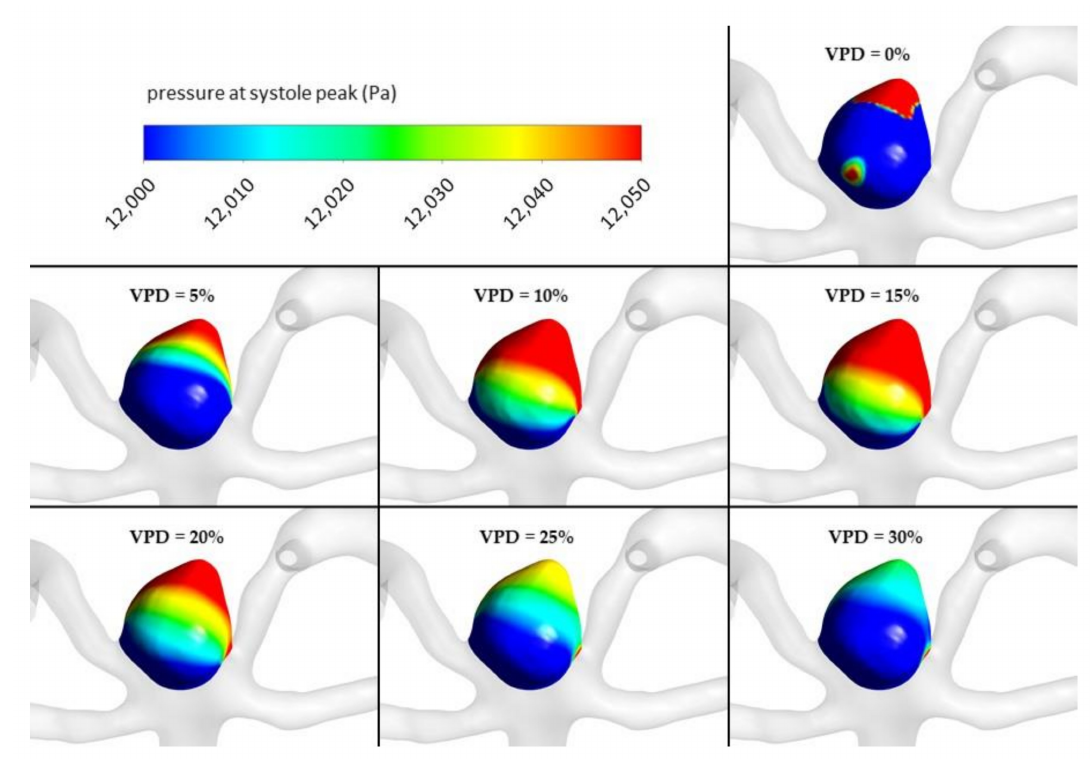
Figure 16. Pressure distribution at aneurysm wall for selected VPD cases; transient simulations—systole peak.